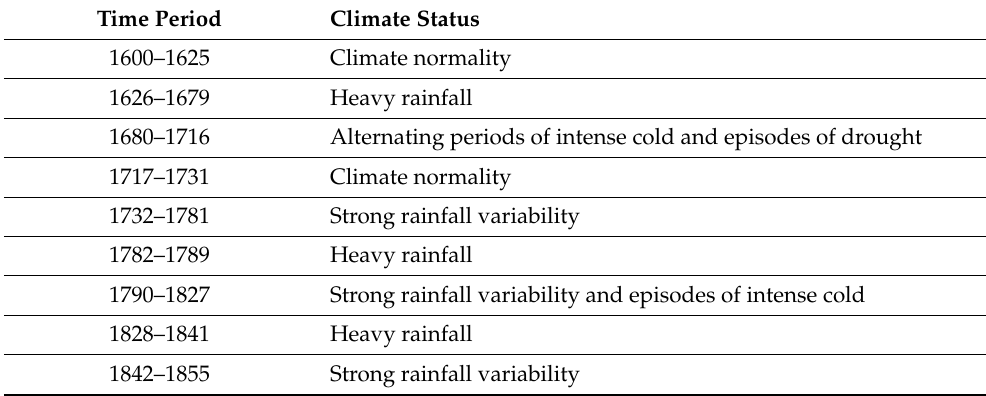
Table 1. Periods depending on the occurrences and the climate conditions in the Entre Douro e Minh (adapted from